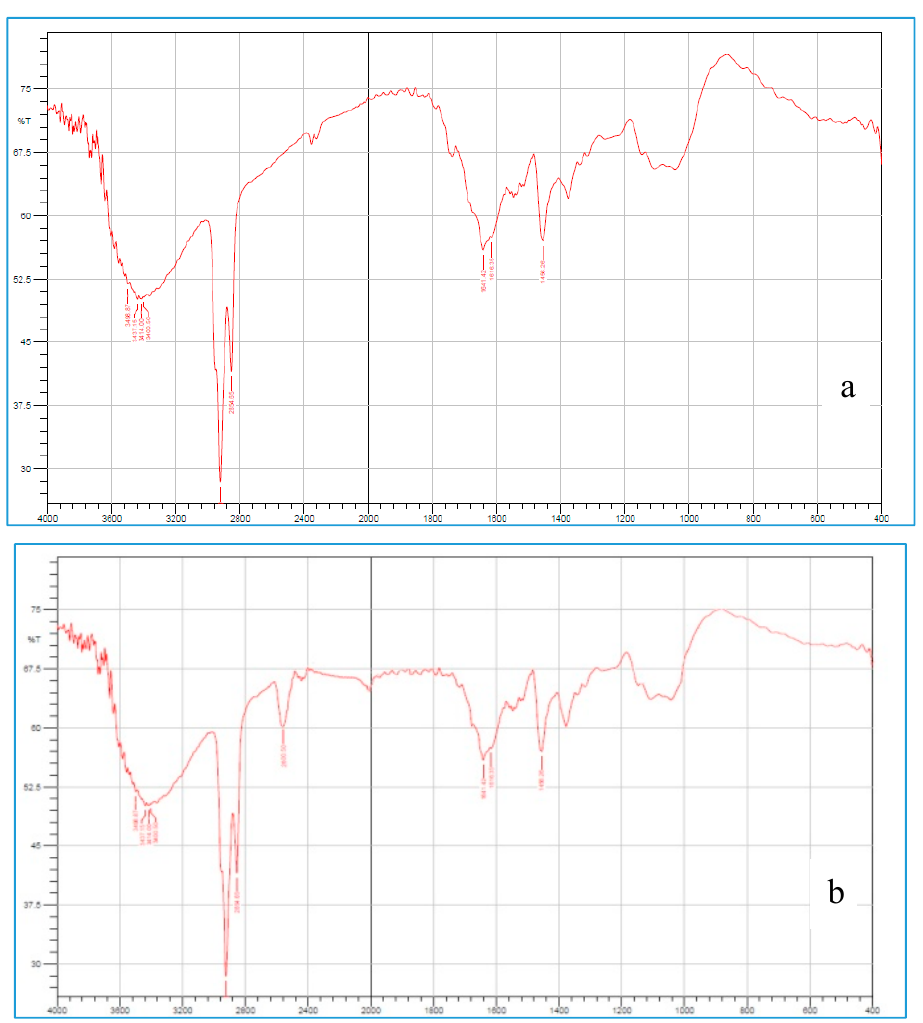
Figure 2. Fourier transform infrared ( FTIR) spectra of okra gum (OG) ( a ) and thiol functionalization of OG (TOG) ( b ).